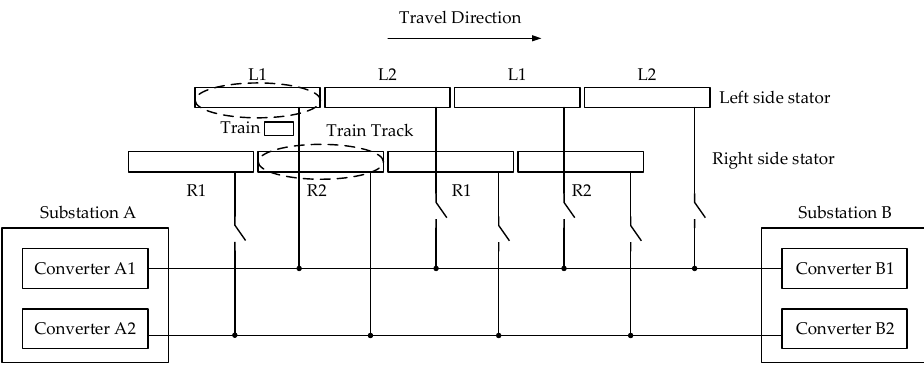
Figure 10. Demonstration of the switching process of the two-step method (Step 2).